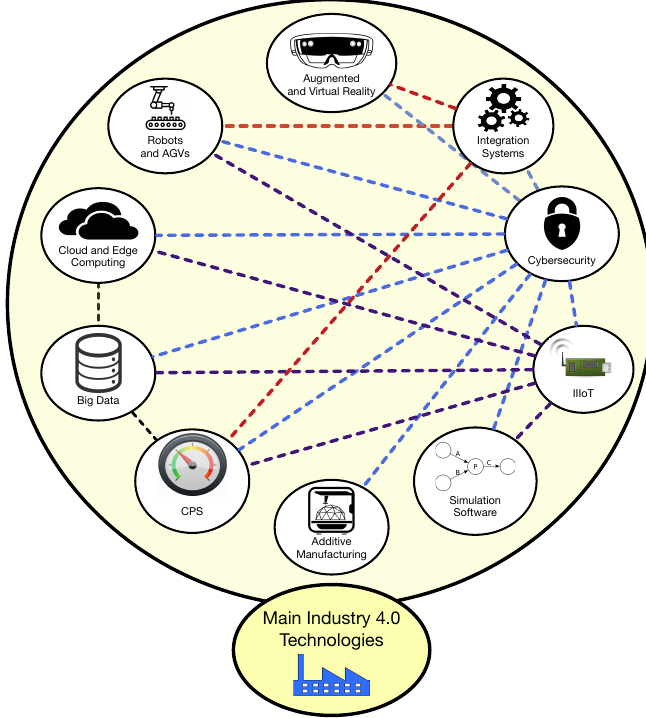
Figure 1. Main Industry 4.0 technologies and their